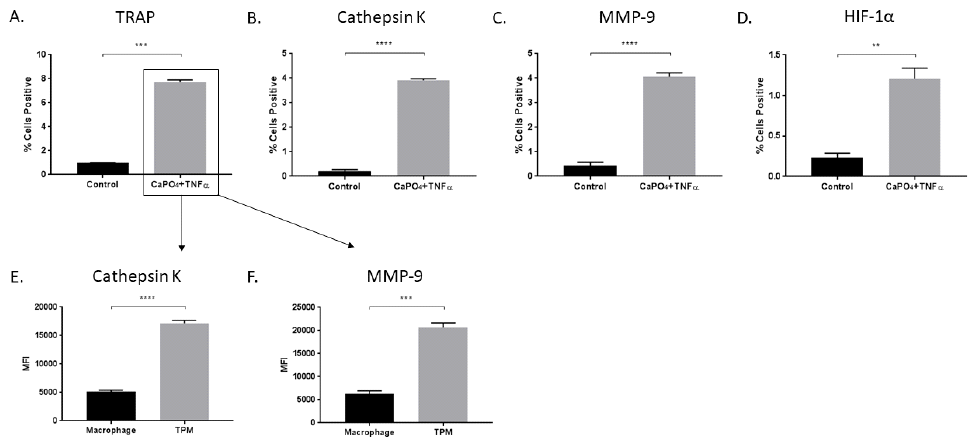
Figure 2. Treatment of macrophages with CaPO 4 and TNF α results in osteoclastogenesis and increased protease production. RAW 264.7 macrophages were treated with CaPO 4 and TNF α and analyzed for the percent of live cells expressing TRAP ( A ), cathepsin K ( B ), MMP-9 ( C ), and HIF-1 α ( D ). ( E , F ) The expression (MFI) of cathepsin K and MMP-9, respectively, in TRAP + cells (TPM) compared to TRAP − cells (macrophage). The data represent three independent experiments. Data are expressed as mean ± SEM. ** p < 0.01, *** p < 0.001, **** p < 0.0001. MFI, median fluorescence intensity.